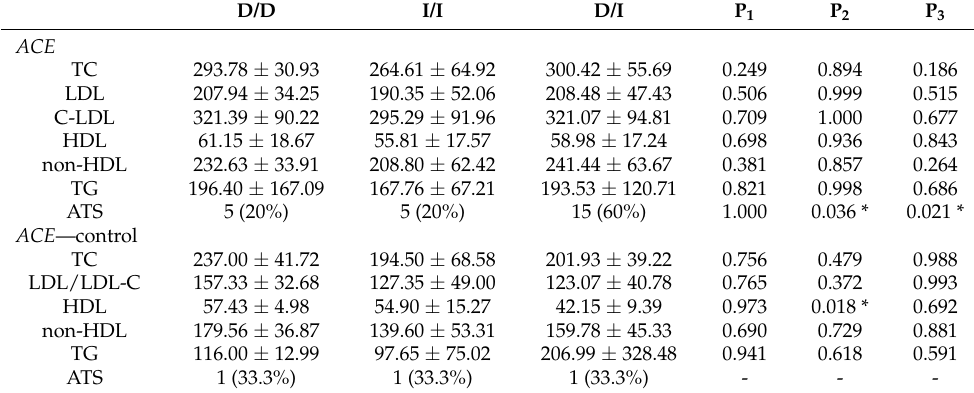
Table 7. Relationship between ACE DI polymorphism with lipid profile and